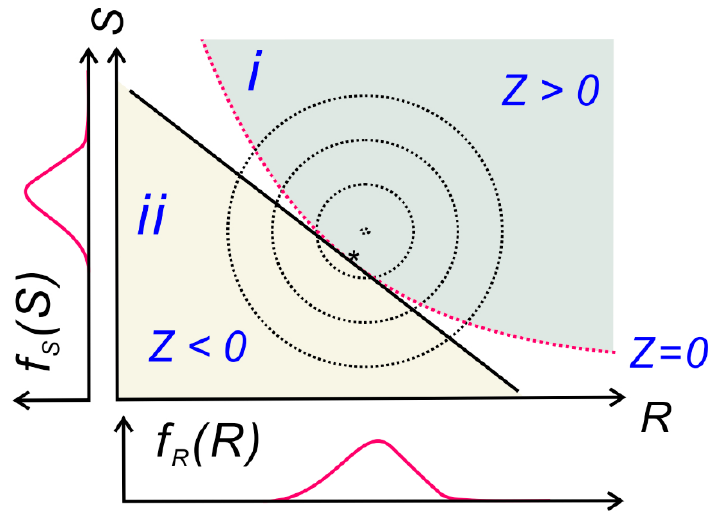
Figure 12. Contour plot of joint of R and S , and the schematic sketch of sample space in [ R , S ] plane representing the un-stability.